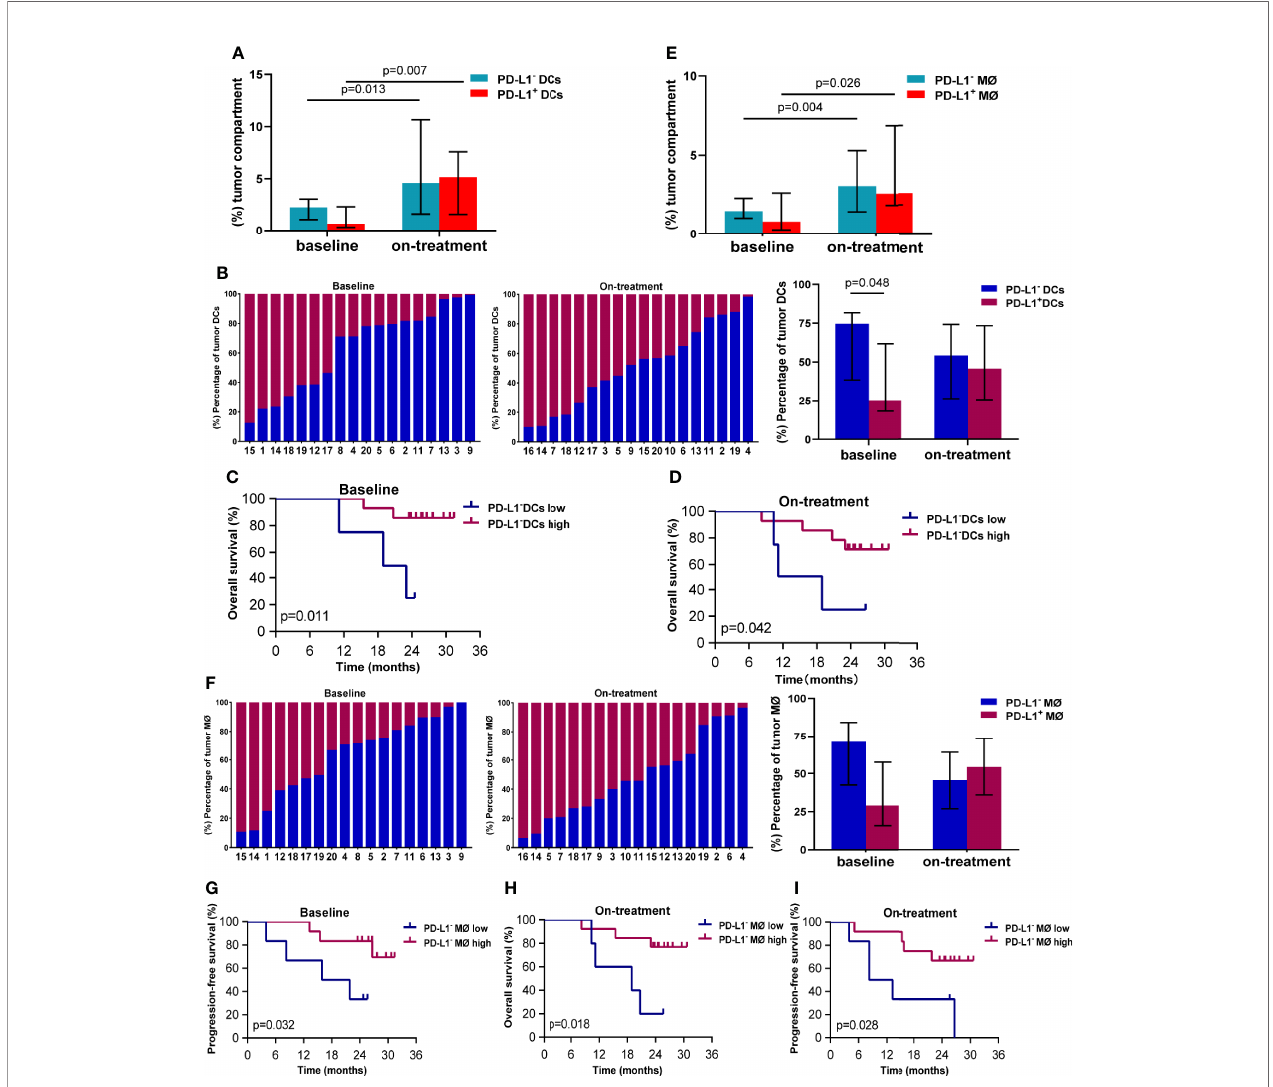
FIGURE 2 | PD-L1 - dendritic cells and macrophages in the tumor compartment associated with better survival. (A) Proportion of PD-L1 - and PD-L1 + dendritic cells in the tumor compartment. (B) Ratio between PD-L1 - and PD-L1 + dendritic cells in the tumor compartment. (C, D) Kaplan – Meier curves showing overall survival based on PD-L1 - dendritic cells in the tumor compartment (C) at baseline (D) and during treatment. (E) Proportion of PD-L1 - and PD-L1 + macrophages in the tumor compartment. (F) Ratio between PD-L1 - and PD-L1 + macrophages in the tumor compartment. (G, I) Kaplan – Meier curves showing overall or progression-free survival based on PD-L1 - macrophages in the tumor compartment (G) at baseline and (H, I) during treatment. The tumors are ordered by the percentage of PD-L1 + dendritic cells or macrophages, from highest to lowest. Cutoff value: (C) ≥ 1.058%; (D) ≥ 1.469%; (G) 1.214%; (H) 1.713%; (I) 2.328%. On-treatment, after 40 Gy radiation. p ≤ 0.05, statistically signi fi Figure 5E and Table 2 ). PD-L1 - macrophages migrated closer to PD-L1 - tumor cells ( p = 0.039), while PD-L1 + macrophages moved away from PD-L1 - tumor cells ( p = 0.026) during the combination treatment ( Figure 5E and Table 2 ). Consequently, opposite to the distances at baseline, PD-L1 - macrophages got closer to PD-L1 - tumor cells than PD-L1 + macrophages during combination treatment ( p = 0.039, Figure 5E and Table 2 ). We then analyzed the distance from PD-L1 + tumor cells to PD-L1 - and PD-L1 + macrophages. The distance from PD-L1 + tumor cells to PD-L1 - macrophages as well as to PD-L1 + macrophages did not alter under the combination treatment ( Figure 5F and Table 2 ).